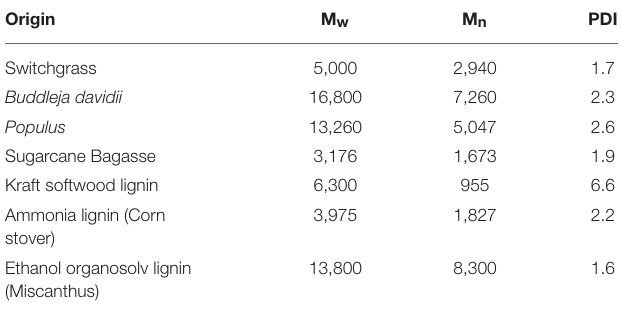
TABLE 2 | Weight-average molecular weight (M w ), number-average molecular weight (M n ), and polydispersity index (PDI) of various lignins. Origin M w M n